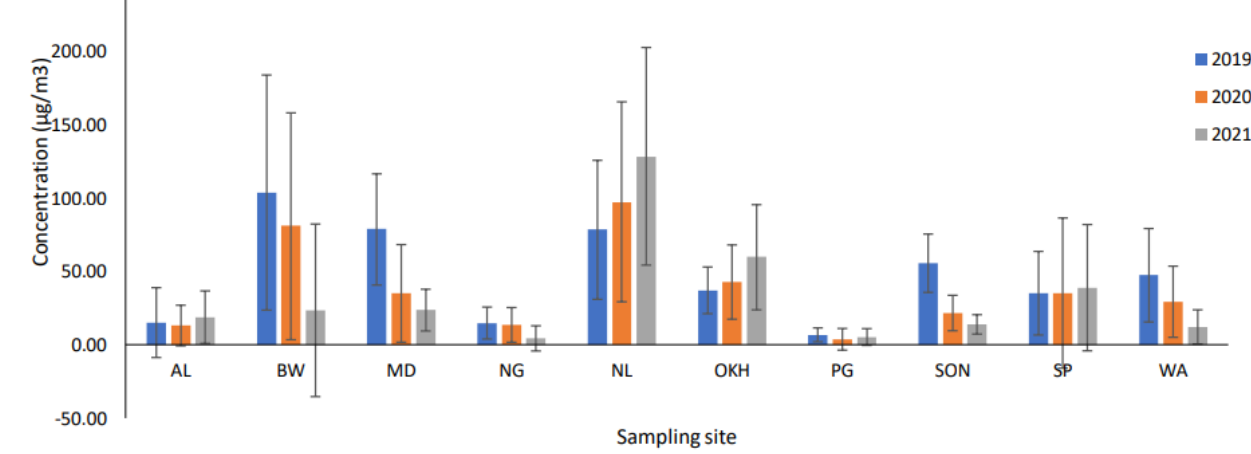
Figure 3. A comparative analysis of TVOCs at all sampling sites for the years 2019, 2020, and 2021.